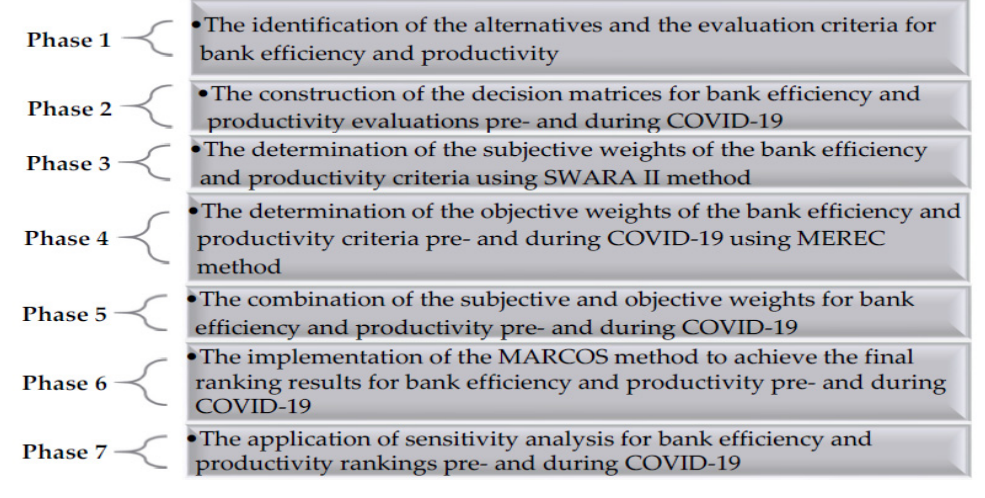
Figure 1. The evaluation procedure of the